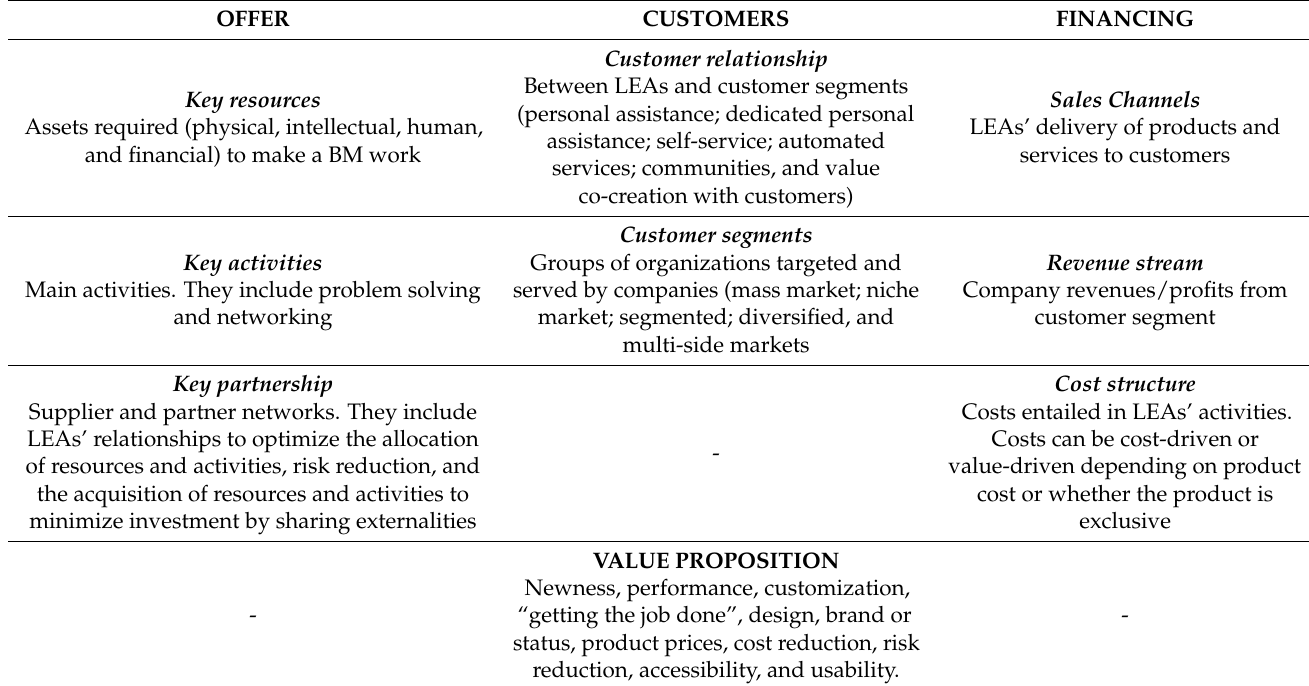
Table 3. Business Model Canvas: nine interconnected components.